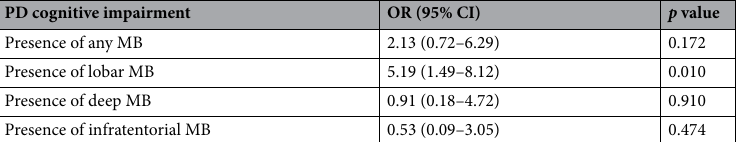
Table 3. Multivariable models for cerebral small vessel disease markers in predicting PD dementia. *Adjusted for age, sex, vascular risk factors, Hoehn-Yahr stage, levodopa equivalent dose, white matter hyperintensity volume, and MRI scanner field strength (1.5 T/3